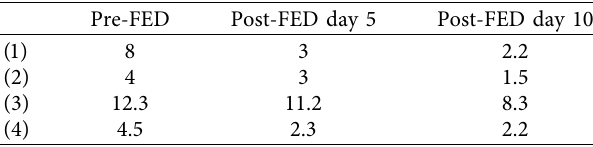
Figure 4: A 71-year-old female was referred because she had severe low back pain after treatment at the Department of Internal Medicine due to urinary tract infection. After spinal endoscopic surgery, low back pain persisted and the patient found difficulty in getting out of the bed; therefore, anterior-posterior lumbar fusion was performed. After the operation, the low back pain improved. (a) Sagittal and axial T2- weighted MRI; an abscess that had formed an air fluid level is identified at the L2/L3 level. (b) Intraoperative view and fluoroscopic image; two portals are inserted on both sides of the intervertebral space, and debridement and irrigation were performed endoscopically. (c) Post- FED sagittal CTscan image showing progress of bone destruction. (d) Post-open surgery sagittal and coronal CTscan view; bone fusion at L2/L3 level was observed 3 months after the minimally invasive open surgery. Table 3: Perioperative change of CRP